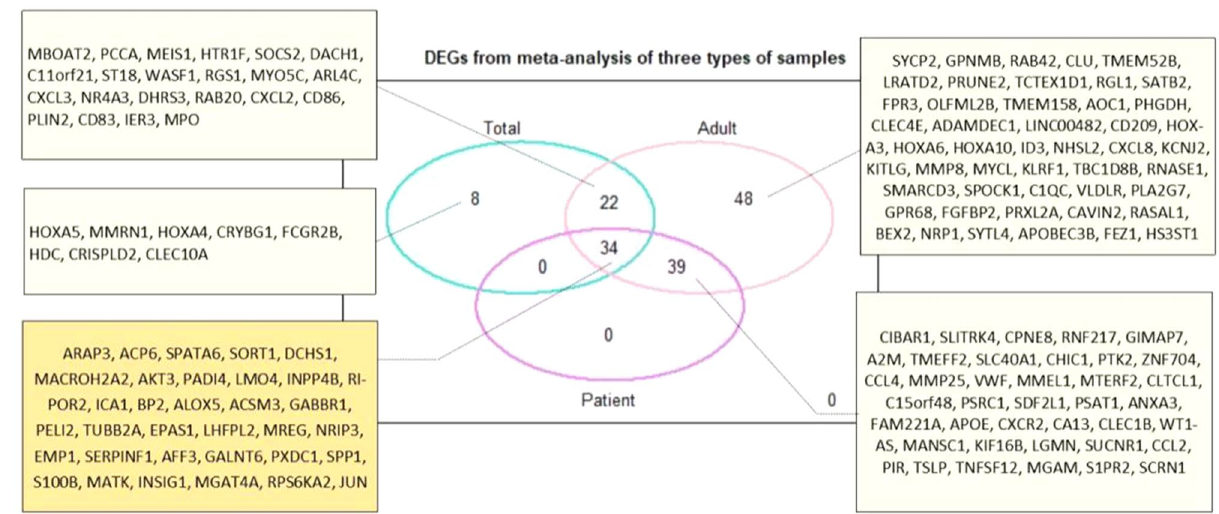
Figure 4. Venn diagram of DEGs. It shows the results of 3 statistical meta-analysis with difference in included sample arrays from all types of sample in total, only patient’s samples, and only adult patient’s samples. 34 genes were identified as common significantly differentially expressed genes (DEGs) between the resistance versus sensitive among all type of analysis (genes with a P value < 0.05 and |fold change|> 1.5 were considered significant). The plot was created using the Package limma version 3.44.3 in R 63